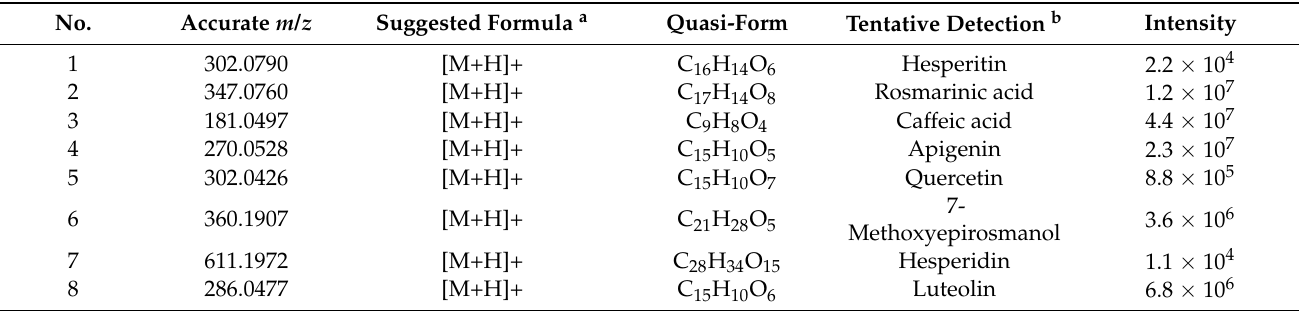
Table 2. High features of compounds (ranked by peak intensity) detected in hydromethanolic extracts of OM after dereplication of their